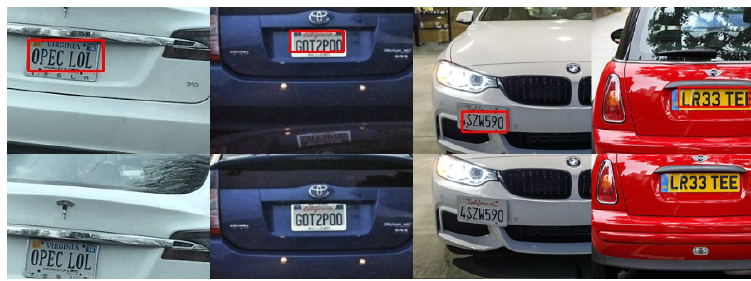
Figure 4. DenseBox car plate